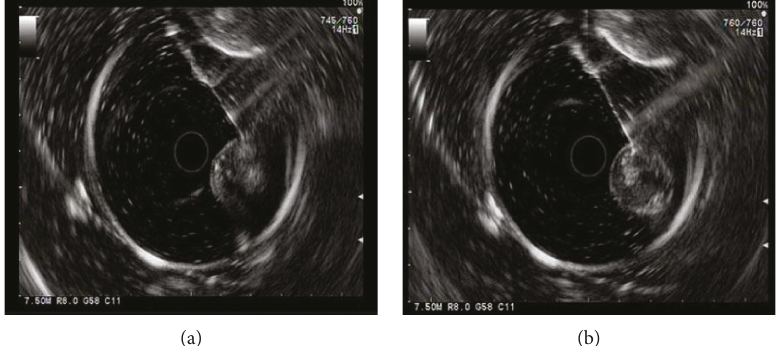
Figure 3: EUS-FNI of ethanol ablation of the orthotopic human pancreatic cancer cell mouse xenografts. (a) Preinjection. To ablate the orthotopic pancreatic cancer cell mouse xenograft, a fi ne needle was inserted into the xenograft lesion. (b) Postinjection. 80% ethanol was injected into the xenograft. Immediately after the injection of 80% ethanol, a hyperechoic area was noted in the tumor